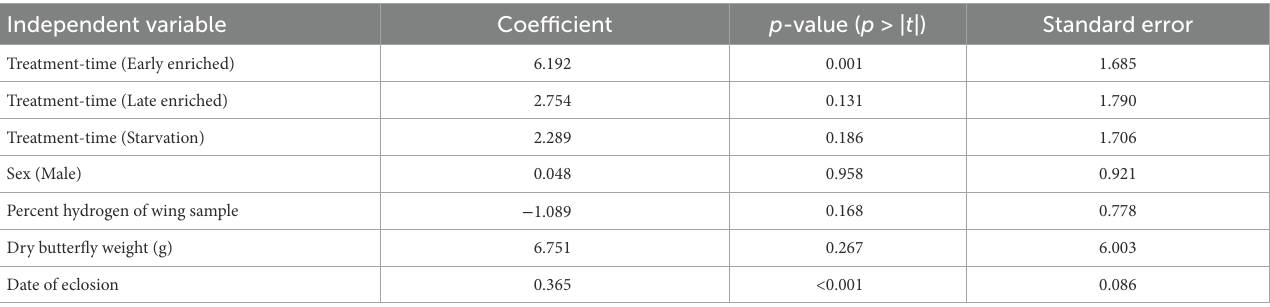
TABLE 1 Table showing the results of the multivariate fixed effect linear regression model for wing δ 2 H with the independent variables (sex, treatment-time, percent hydrogen of wing sample, date of eclosion and dry weight of butterfly), coefficient of variable in linear regression, and p -value depicting the significance of the correlation, and the standard error for the variable.